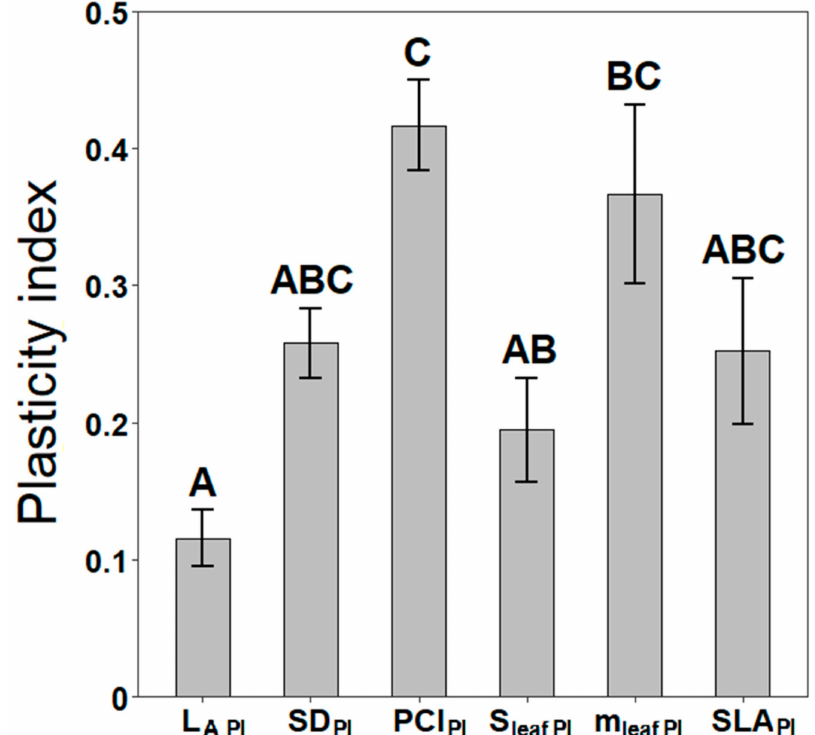
Figure 4. Phenotypic plasticity indices of stomatal density (SD PI ), guard cell length ( L A PI ), the potential conductance index ( PCI PI ), leaf size ( S leaf PI ), leaf dry weight ( m leaf PI ) and specific leaf area ( SLA PI ) for each provenance. Plasticity indices obtain values of 0 to 1, where 0 denotes no plasticity and 1 denotes theoretical maximal plasticity. Confidence intervals represent standard error and the capital letters correspond to results of post-hoc